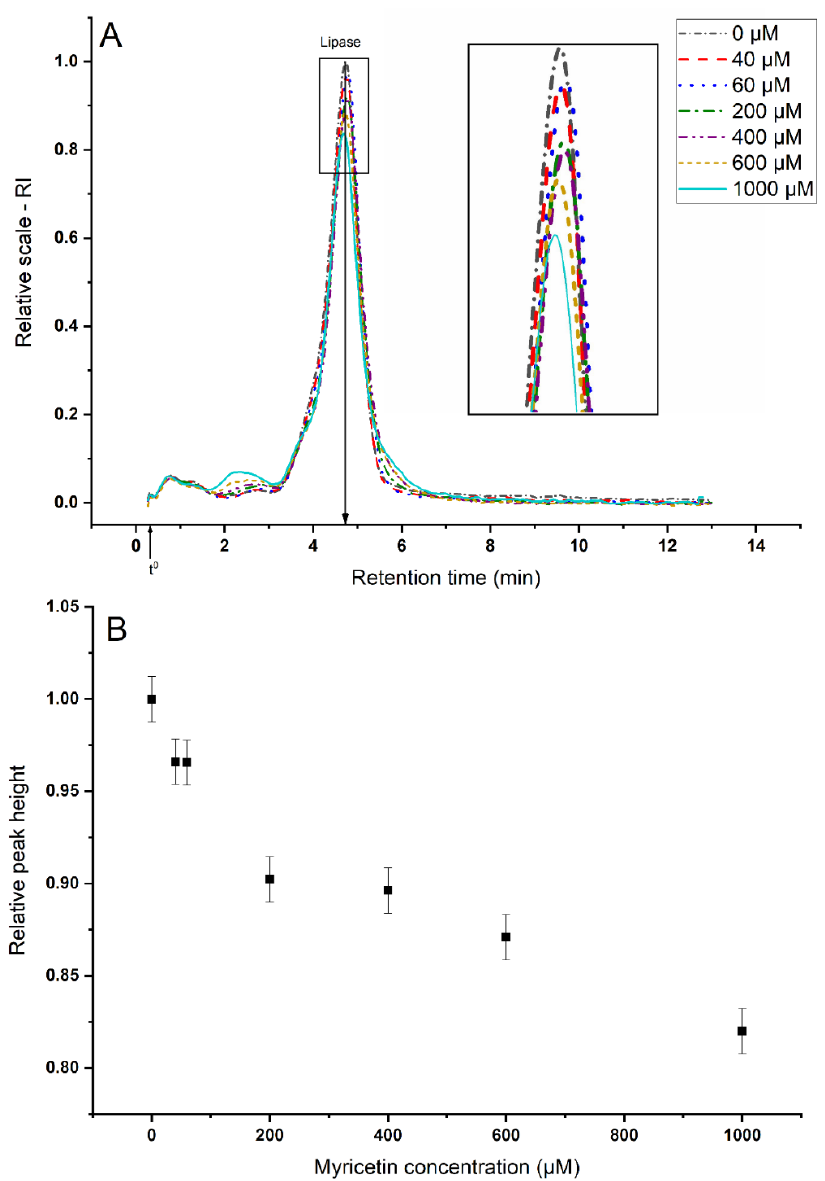
Figure 3. AF4–dRI analyses of the remnant pancreatic lipase after its interaction with di ff erent concentrations of myricetin (the sample was filtered before the analyses, see Section 2.4.1). ( A ) Fractograms. ( B ) Relative di ff erential refractive index (dRI) peak heights of lipase vs. myricetin concentration. t 0 denotes the void time at 19 sec.